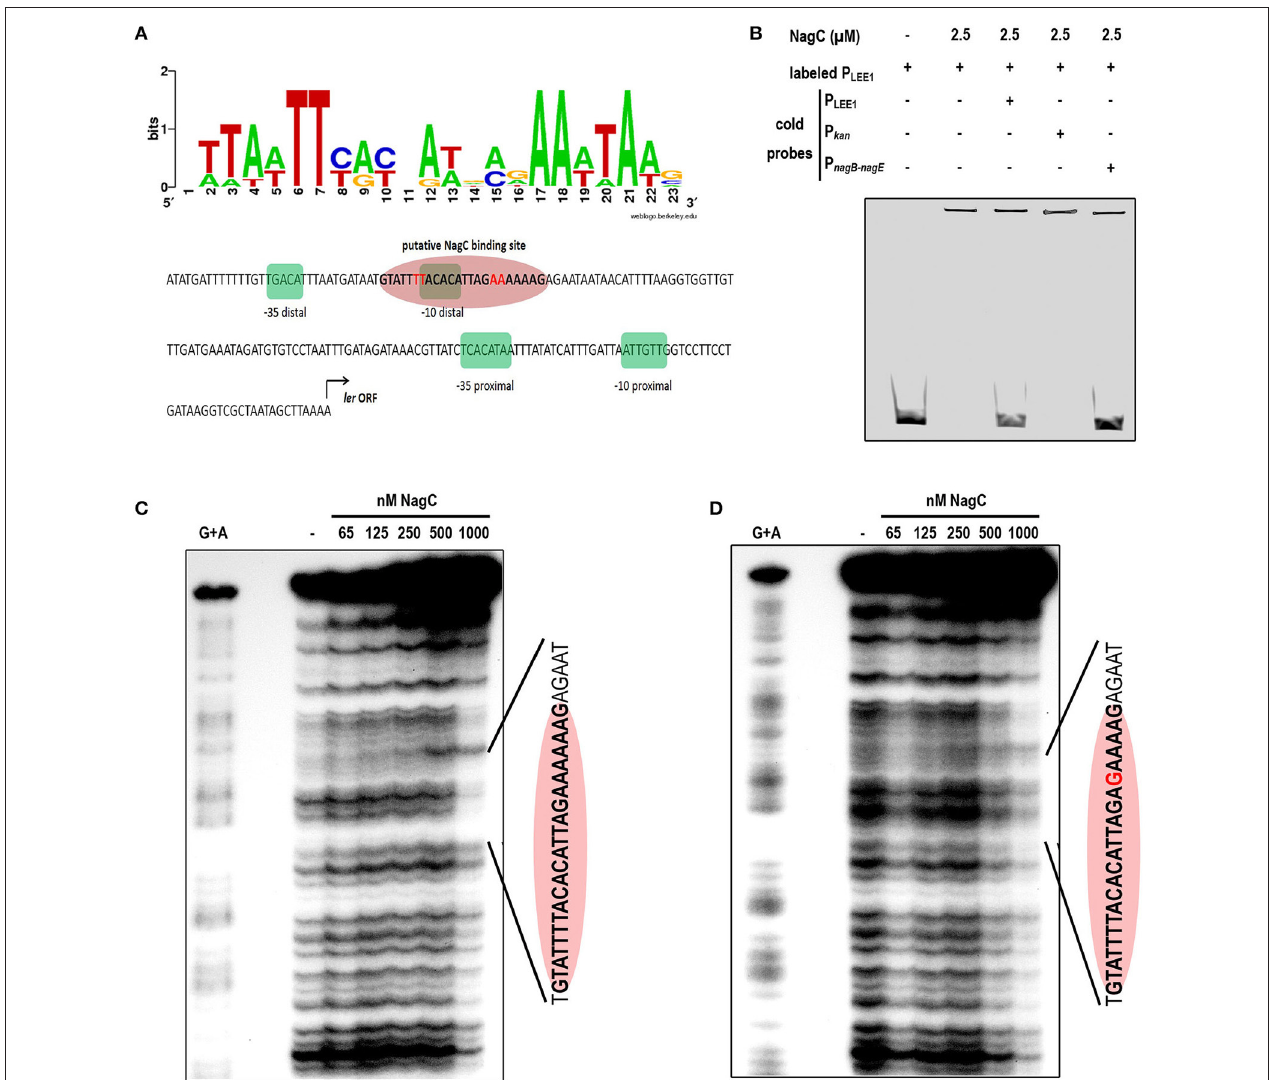
FIGURE 3 | NagC binds in vitro to the promoter of LEE1. (A) Predicted binding site generated by Weblogo from seven known NagC binding sequences and schematic representation of the regulatory region of LEE1. The − 35 and − 10 boxes of the proximal and the distal promoters are highlighted in green and the putative NagC binding site in red. (B) Competitive EMSA assays were performed using purified NagC (2.5 µ M) and a 6-FAM labeled P LEE1 probe (50nM) and unlabeled probes corresponding to P LEE1 , P kan (negative control) or P nagB − nagE (positive control). (C) Footprinting experiment was performed with end-labeled PCR product of the native LEE1 regulatory region and purified NagC. The DNA sequence of the protected region is indicated and includes the NagC putative binding sequence (red ellipse). (D) Footprinting experiment was performed with end-labeled PCR product of the mutated LEE1 regulatory region. The base substitution (A → G) is indicated in